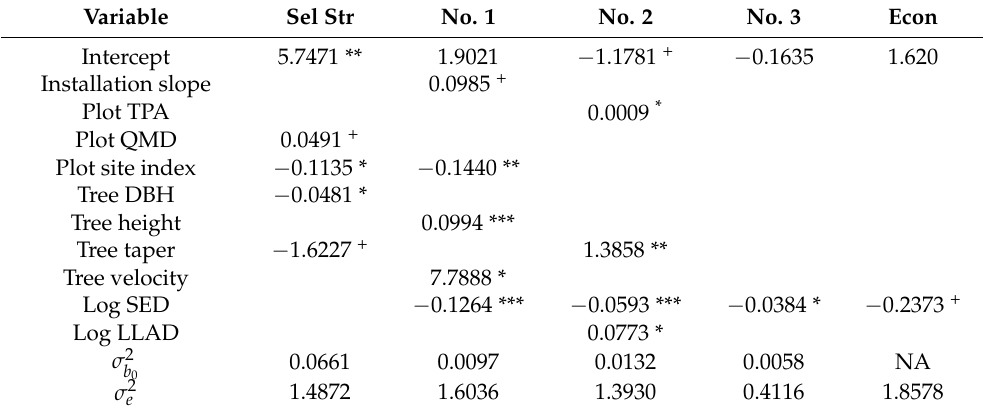
Table 6. Selected parameters and level of significance for the lumber visual grade abundance models.